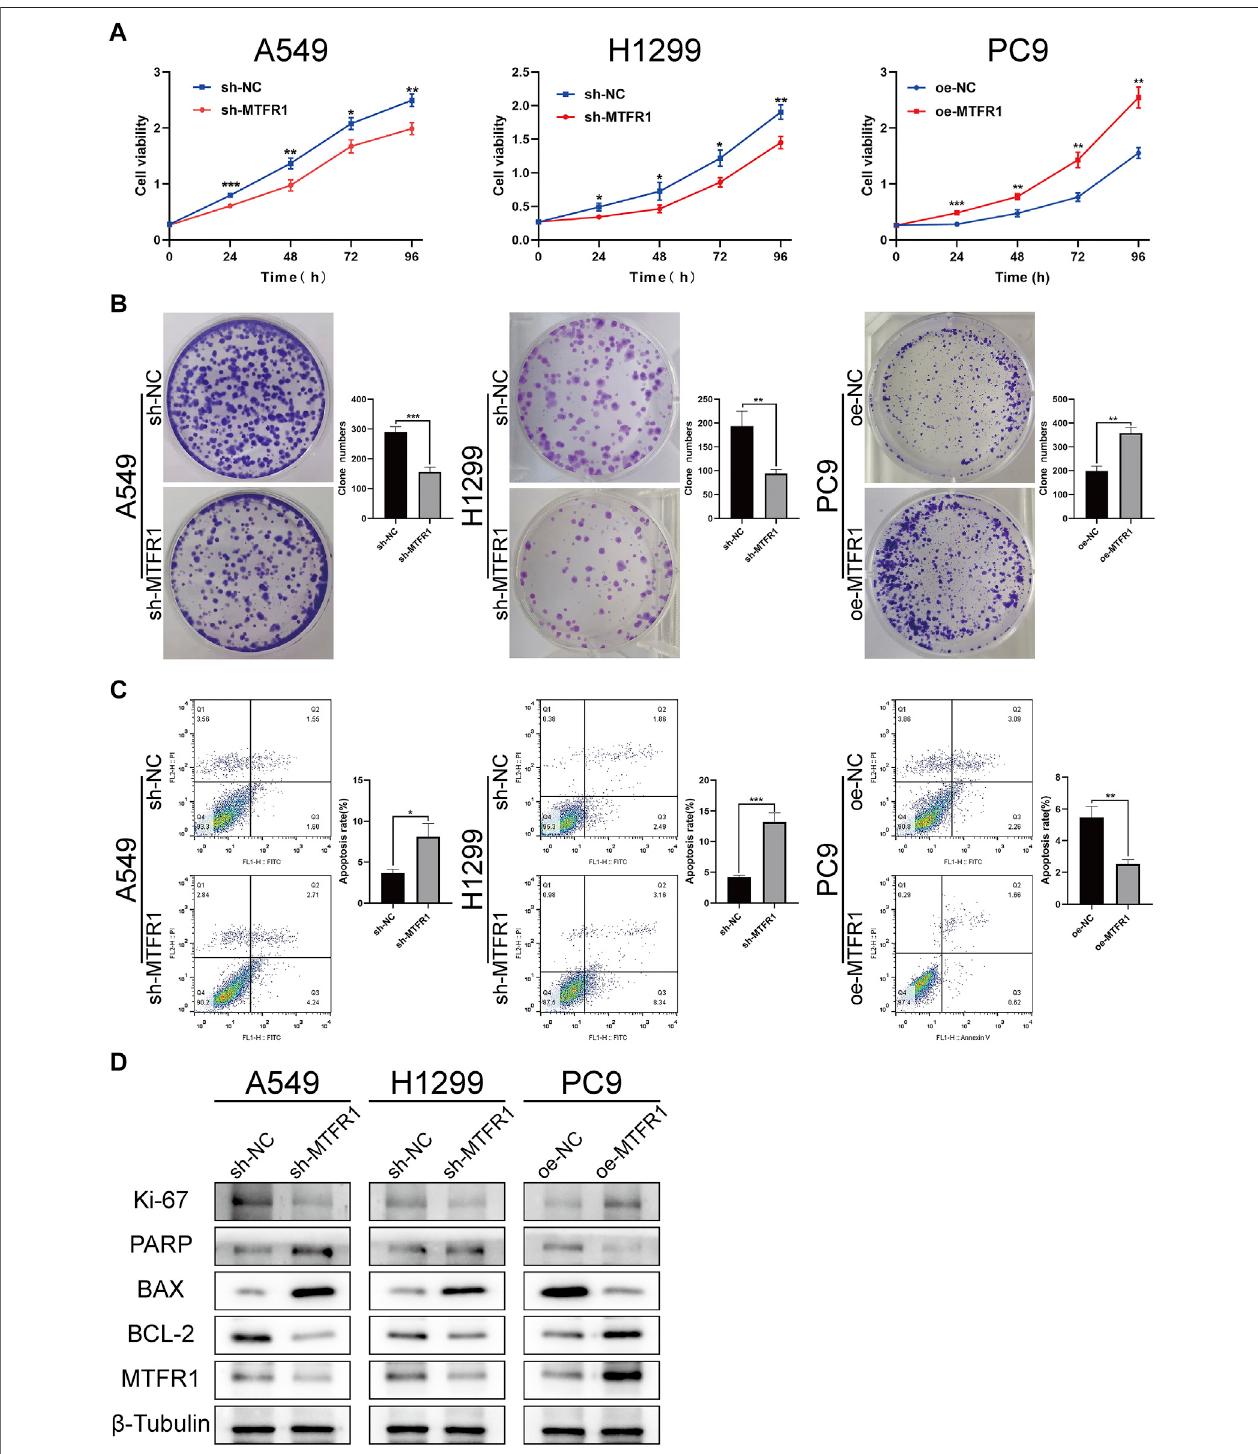
FIGURE 3 | MTFR1 stimulated proliferation and suppressed apoptosis of LUAD cells. (A) Cell Counting Kit-8 (CCK-8) assay of the transduced cells. (B) Colony formationassayofthetransducedcells. (C) Evaluation ofapoptosisby fl owcytometry. (D) Evaluation oftheexpression ofcellproliferationand apoptosis-related protein by WB. Data were articulated as the mean ± standard deviation (SD; * p < 0.05, ** p < 0.01 *** p < 0.001).